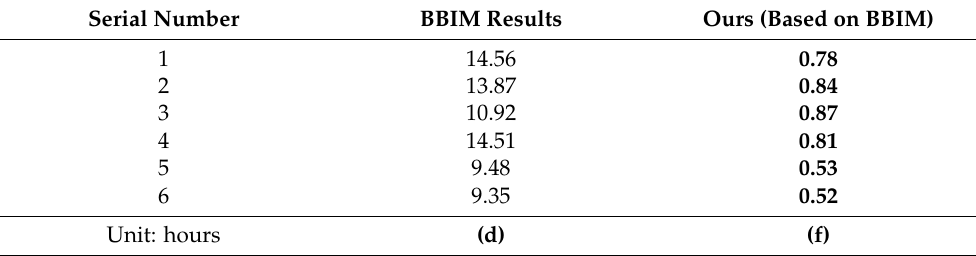
Table 4. RGB Image inpainting time